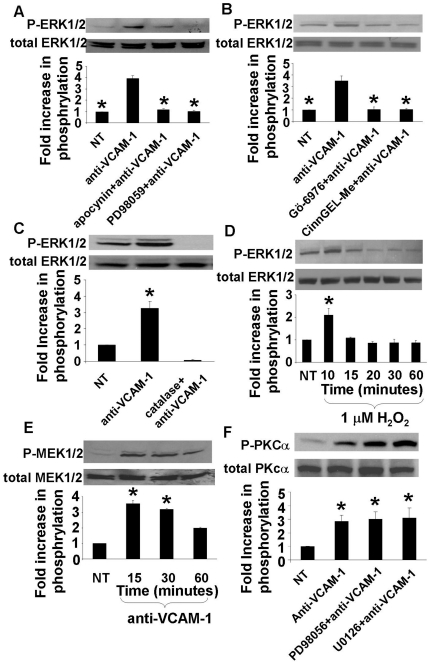
Mechanisms for VCAM-1 activation of ERK1/2 in endothelial cell lines.Monolayers of mHEVa cells were nontreated (NT) or incubated for 30 minutes with apocynin (4 mM), PD98059 (30uM), U0126 (40 µM), Gö-6976 (2.3 nM), CinnGEL 2-methylester (10 µM), or catalase (5000 U/ml) where indicated. These are the optimal doses for these inhibitors as we have previously described [5], [7], [8]. At these concentrations, none of the inhibitors had any significant effects on the basal level of ERK1/2 in the absence of anti-VCAM-1 stimulation (data not shown). After treatement with the inhibitor, the endothelial cells were stimulated with anti-VCAM-1 antibody plus a secondary antibody to crosslink VCAM-1 for 30 min under static conditions. We examined phosphorylation of A,B,F) ERK1/2 Thr202/Tyr204 (P-ERK1/2), C) PKCα Thr638 (P-PKCα), or D) MEK1/2 Ser217/221 (P-MEK1/2) by western blot. E) mHEVa cells were treated with exogenous 1 µM H2O2 for 10–60 minutes and ERK1/2 Ser217/221 phosphorylation was determined by western blot. The phosphorylation status of ERK1/2 Thr202/Tyr204, PKCα Thr638, or MEK1/2 Ser217/221 is presented as the fold increase in the ratio of the relative intensity of the phosphorylated enzyme to total ERK1/2, total PKCα or total MEK1/2 expression. Representative western blots are shown and data are presented as the mean ± standard deviation from 3 experiments. (A, B) *, p<0.05 less than anti-VCAM-1-treated group. (C–F) *, p<0.05 greater than NT.